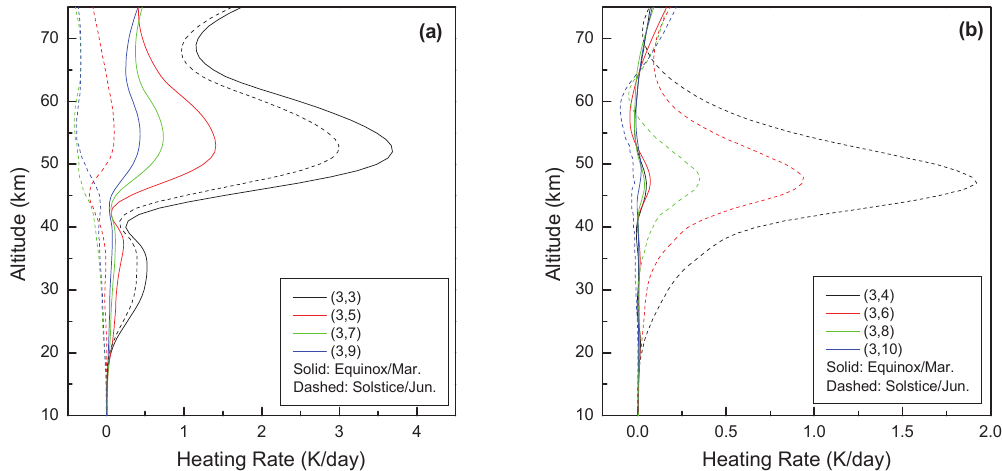
Fig. 14. Multi-year averaged vertical profiles of the symmetric (a) and asymmetric (b) terdiurnal Hough functions for equinox/March (solid line) and solstice/June (dashed